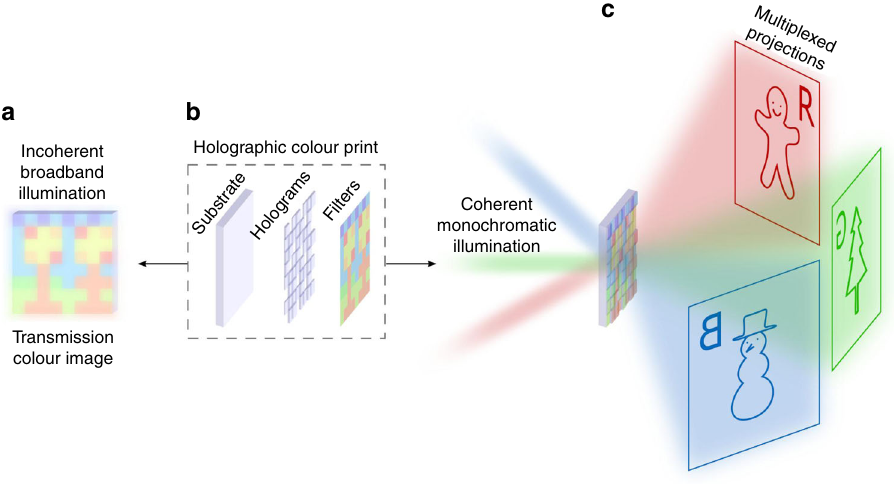
Fig. 1 Illustration of a holographic colour print. Exploded-view schematic of a transmission holographic colour print ( b ), a layered optical device in which colour fi lters are integrated on top of holograms. The colour fi lters act as colour pixels in a colour image under white light illumination from a lamp or torch ( a ) and also serve to control the transmission of red, green, and blue (RGB) laser light through the pixels of the underlying multiplexed holograms ( c ). Under RGB laser illumination, each wavelength of light selects a different holographic projection, which is independent of the colour image and the other projections. Far fi eld projections appear along the axis of laser illumination. Three different angles of incidence are shown to illustrate the three distinct holographic projections. The projections remain in focus at any distance in the far fi eld, can be achieved over a wide range of incident angles, and are perfectly overlapped under collinear multi-colour illumination